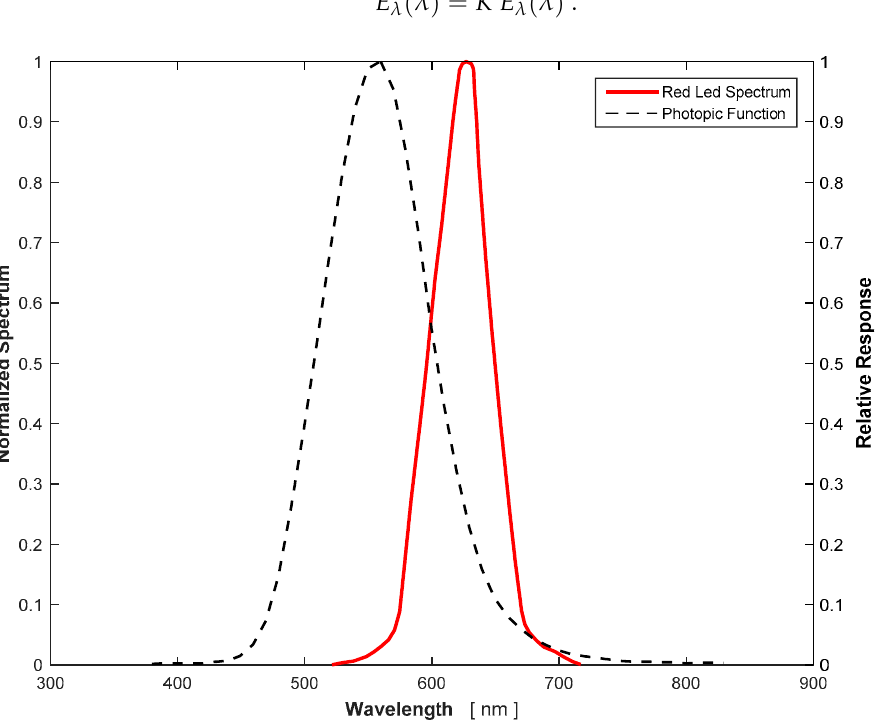
Figure 8. Normalized red led spectrum and photopic function. Provided that the distance between the light source and the orientation of the lux meter and the photodiode sensors are the same (this can be ensured by the set-up), the constant K can be determined from the lux meter E v measurements as: